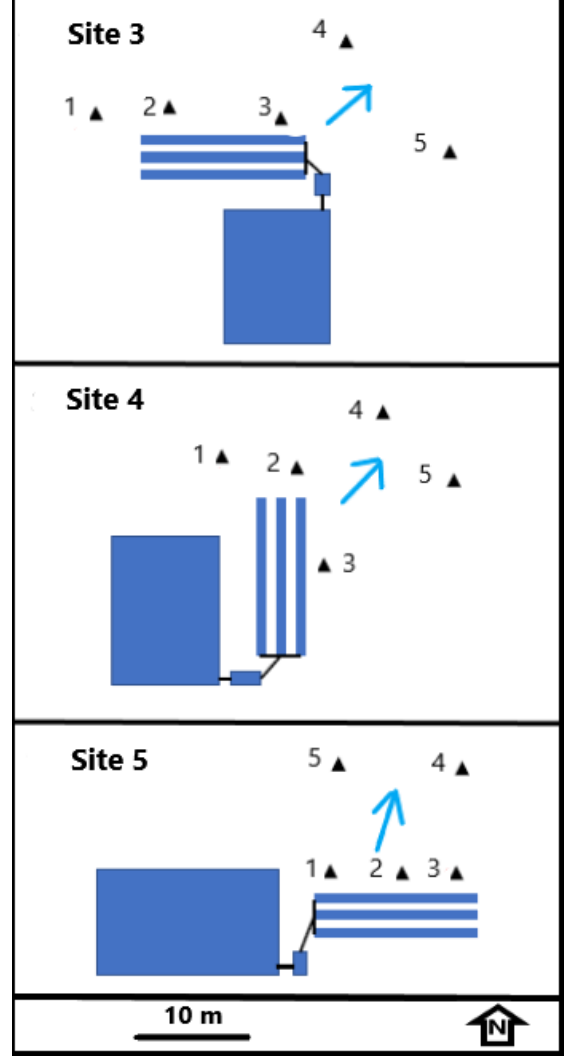
Figure 4. Groundwater monitoring infrastructure at Sites 3 – 5, including nests of piezometers near the drainfields sampled for water quality (#1 – 3) and nests of piezometers away from the drainfields (#4 – 5) used to determine hydraulic gradients and groundwater flow direction. Samples at Sites 3 and 4 collected from piezometer nest number 1 were considered background samples based on flow direction and drainfield orientations at those properties. The background groundwater data from Sites 3 and 4 were pooled and also served as the background for Site 5.